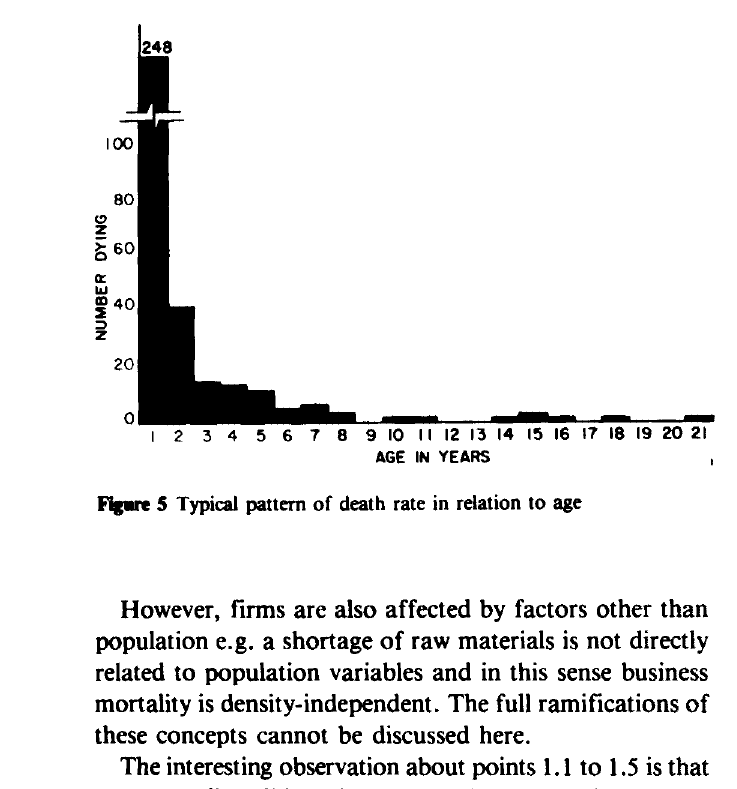
Flpre S Typical pattern of death rate in relation to